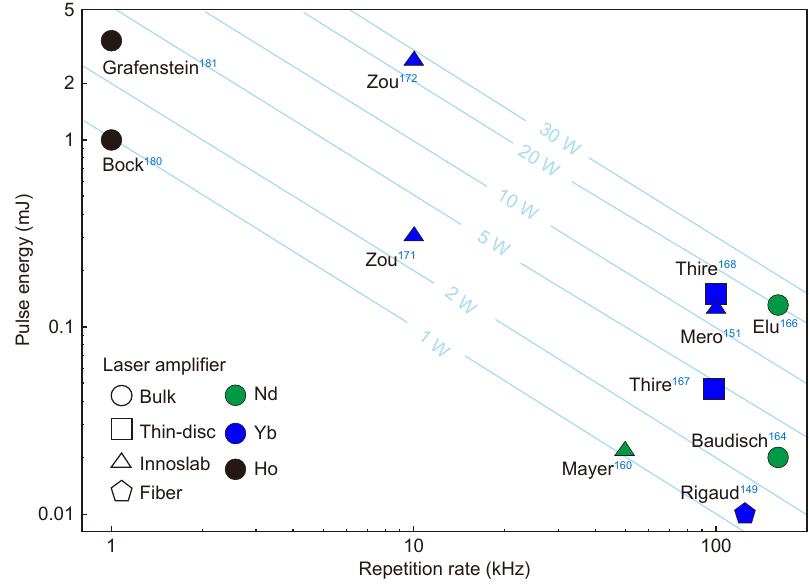
Fig. 7 | Graphical summary of the performance of high average power MIR OPCPA systems. Color coding of data points denotes the gain medium of pump laser, while different shapes indicate the configuration of laser